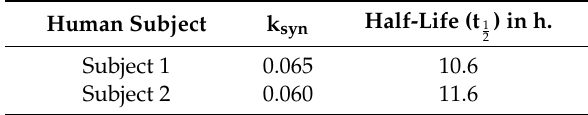
Table 4. The measured half-life of FcRn in PBMCs from two human